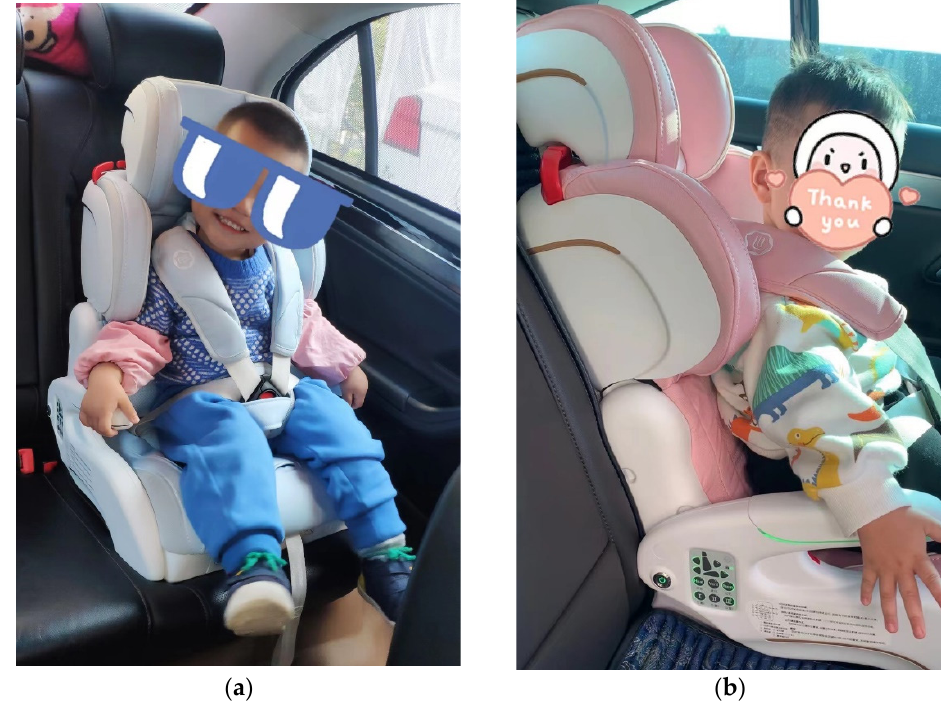
Figure 11. ( a , b ) The smart child restraints were installed in the participant’s